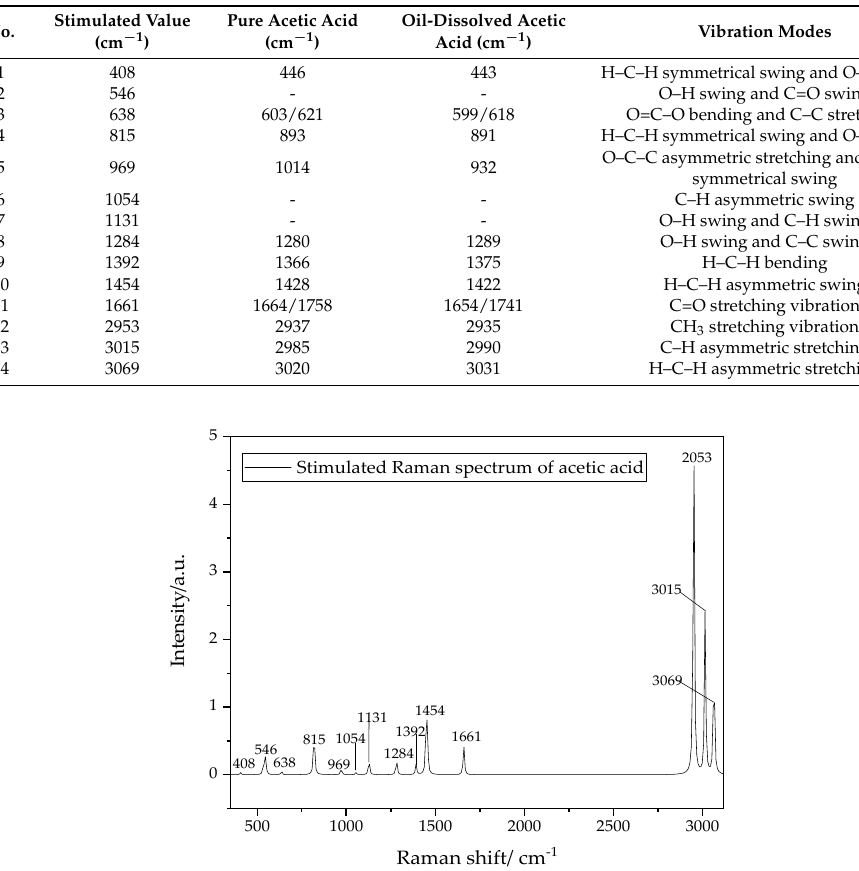
Figure 2. Experimental Raman spectrum of pure acetic acid. Table 1. Raman shift spectral lines of acetic acid.